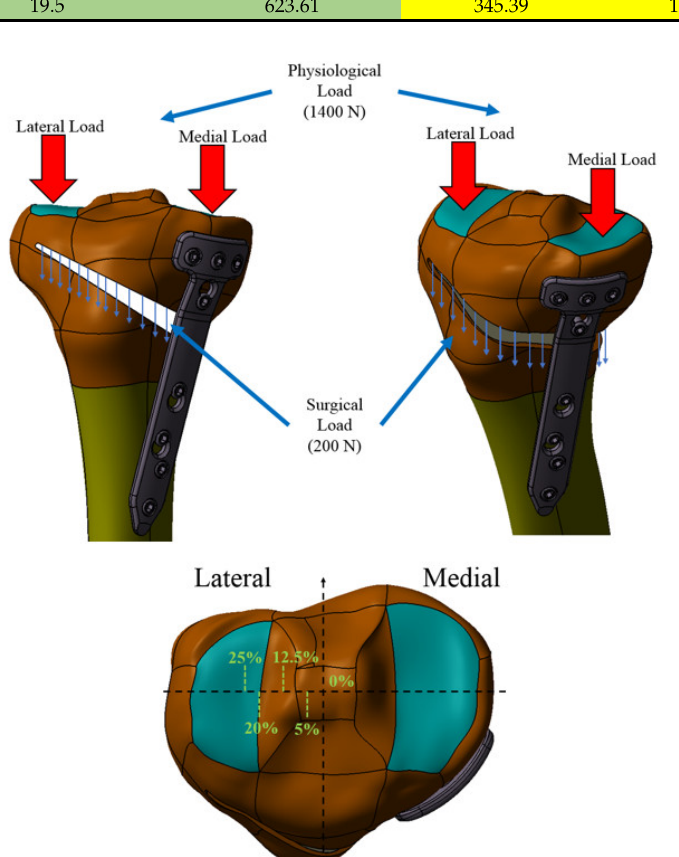
Figure 9. Loads on the ankle joint. Table 2. The load values depending on the change in the position of the mechanical axis.